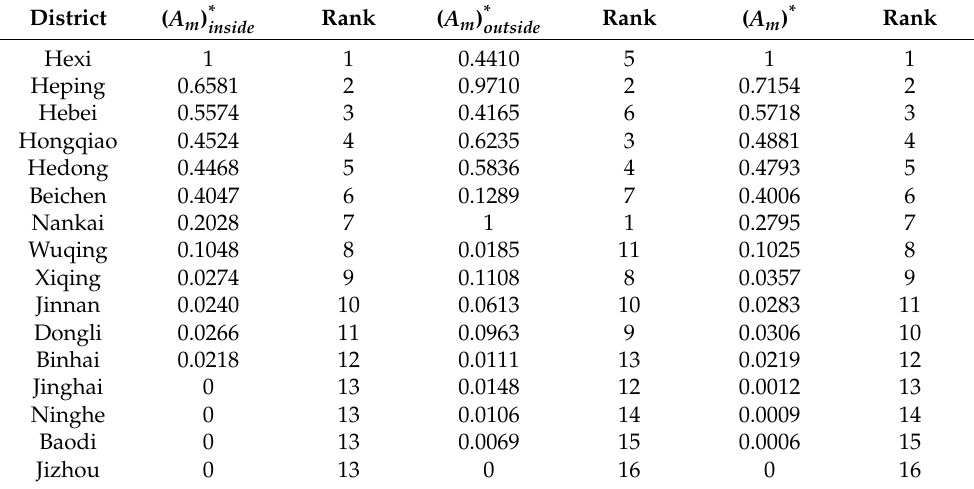
Table 1. Accessibility to tertiary hospitals in